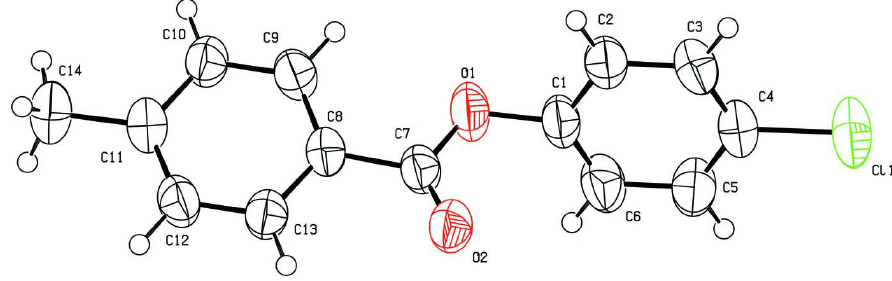
Molecular structure of the title compound, showing the atom labeling. Displacement ellipsoids are drawn at the 50% probability level. H atoms are represented as small spheres of arbitrary